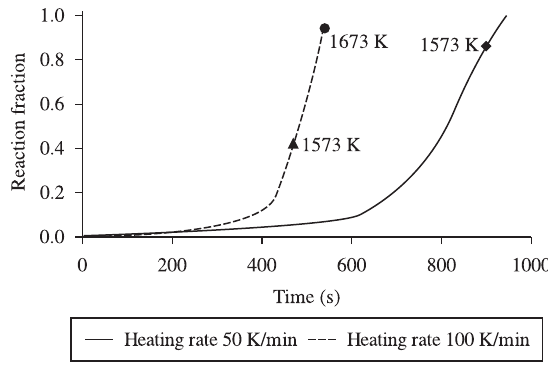
Figure 4. Reaction fraction as a function of time for non-isothermal reduction of iron ore by graphite; the starting time was taken when the temperature was 773 K.